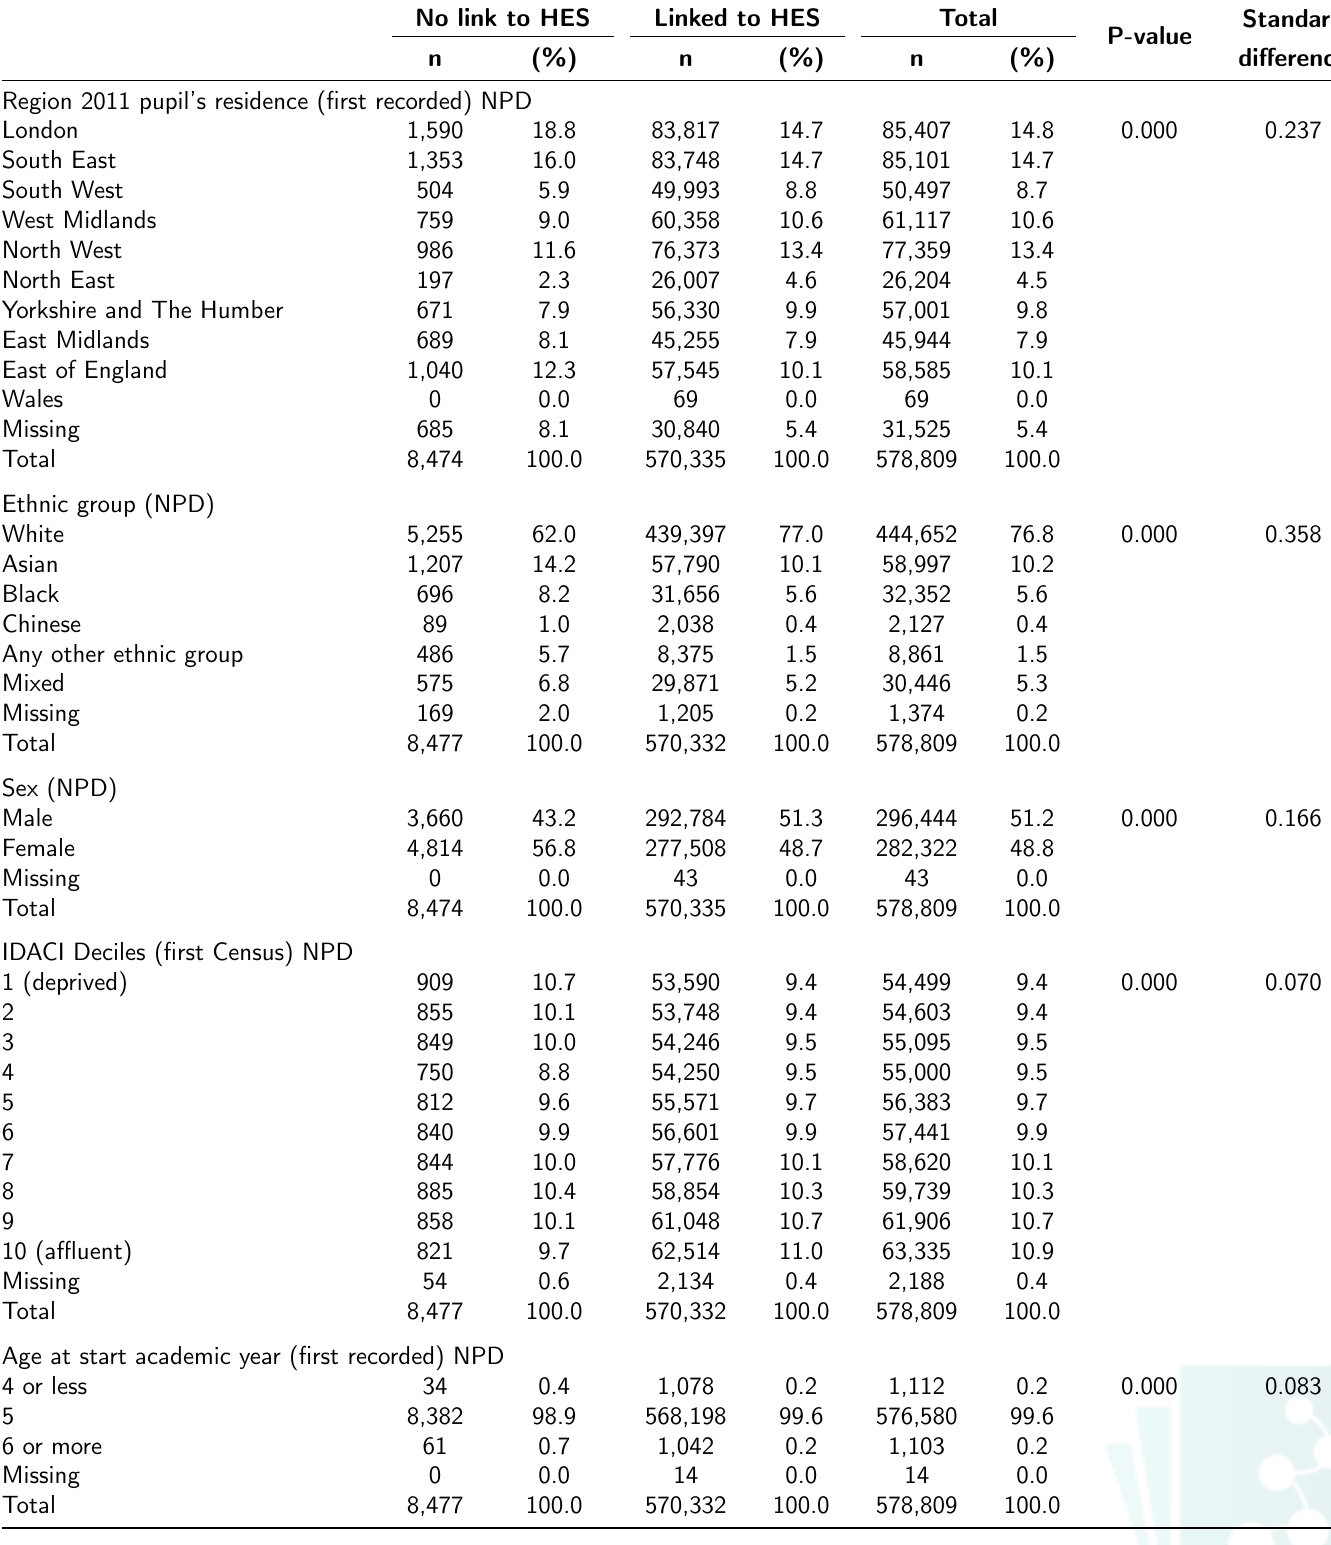
Supplementary Table 9.4: Distribution of demographic variables in national pupil dataset by linking status, N = 578,809 pairs (national pupil dataset to hospital episode statistics). Cohort